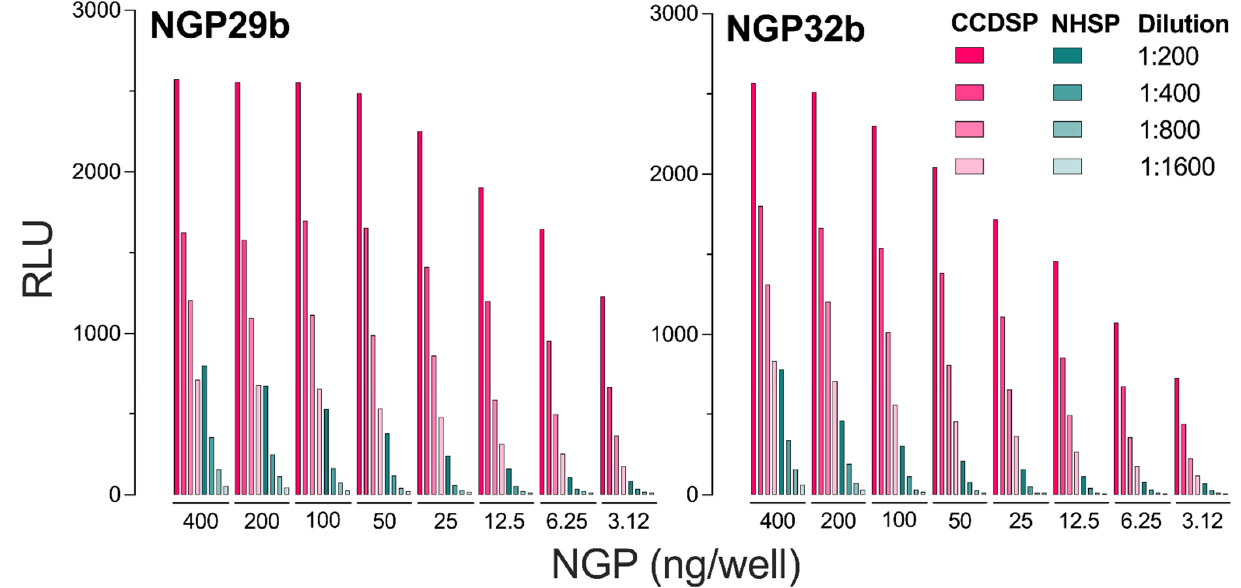
Figure 2. Antigen and serum cross ‐ titration by CL ‐ ELISA of NGP29b and NGP32b . This experiment aimed to identify CL ‐ ELISA conditions that give the largest differential reactivity between CCD sera (red) and NHS control group (green). Both NGPs were titrated at different concentrations (3.12, 6.25, 12.5, 25, 50, 100, 200, or 400 ng/well) with serum pools from ten CCD patients and from ten healthy individuals, both diluted at 1:200, 1:400, 1:800, or 1:1600. The CL ‐ ELISA was performed as described in the Supplementary Material. CCDSP, CCD serum pool; NHSP, normal human serum pool; RLU, relative luminescence units.